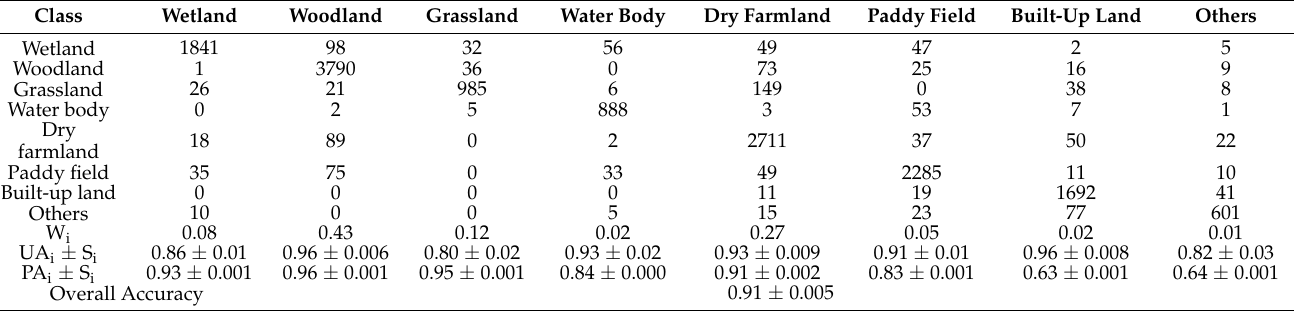
Table 4. Areal adjusted confusion matrix of land cover map of 2010 (the standard error was presented with a 95% confidence